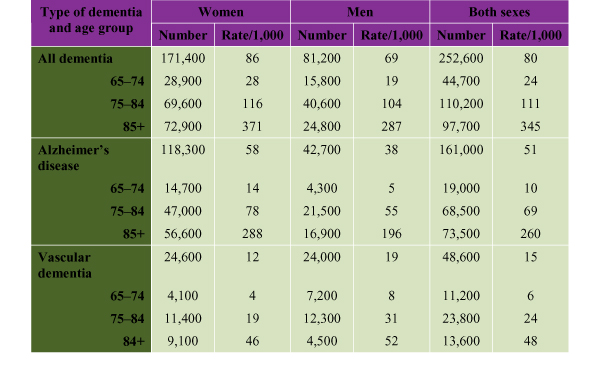
Prevalence of dementia in Canada, 1991, by type of dementia, sex and age group – numbers and rates per 1,000 population Source: Canadian Study of Health and Aging Working Group. Study methods and prevalence of dementia.[3]